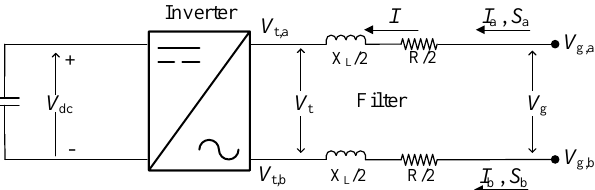
Figure 5. Physical model of a single-phase line-to-line power electronic interface.